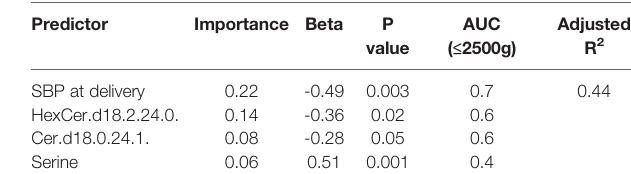
TABLE 3 | List of indicators associated with birth weight.